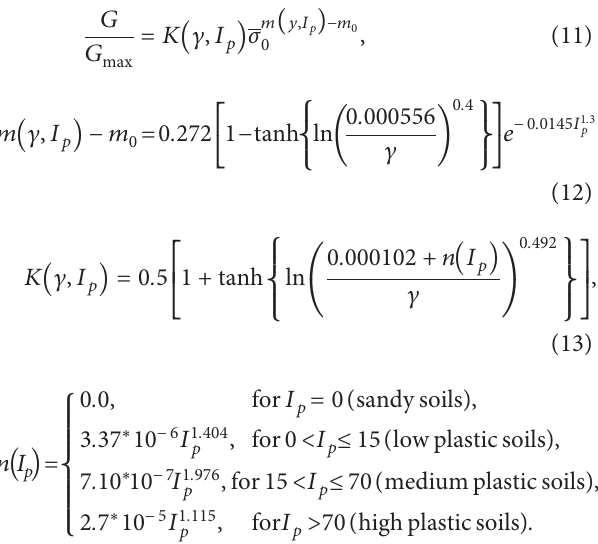
Figure 2: Calibration of parameters C and λ